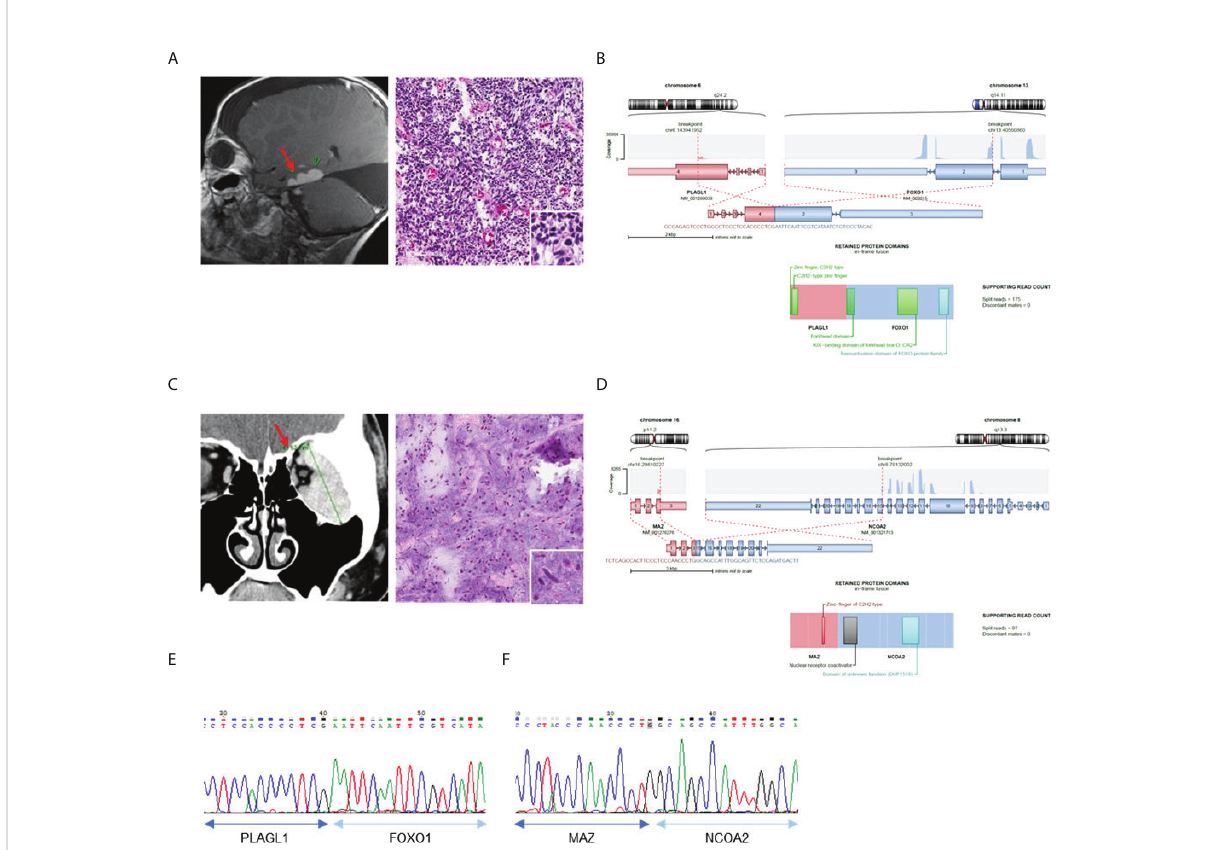
FIGURE 3 Con fi rmation of novel fusions. (A) MRI brain image show tumor in left temporal lobe (left) and H&E staining of tumor tissue (right). (B) Schematics of PLAGL1-FOXO1 and remaining protein domains of fusion. (C) MRI of left orbit with myxoid soft tissue lesion (left) and H&E staining of myoepithelioma (right). (D) Schematics of MAZ-NCOA2 and remaining protein domains of fusion. (E) Con fi rmation of PLAGL1-FOXO1 fusion expression using RT-PCR. (F) Con fi rmation of MAZ-NCOA2 fusion expression using RT-PCR *Red sparrow indicate tumor